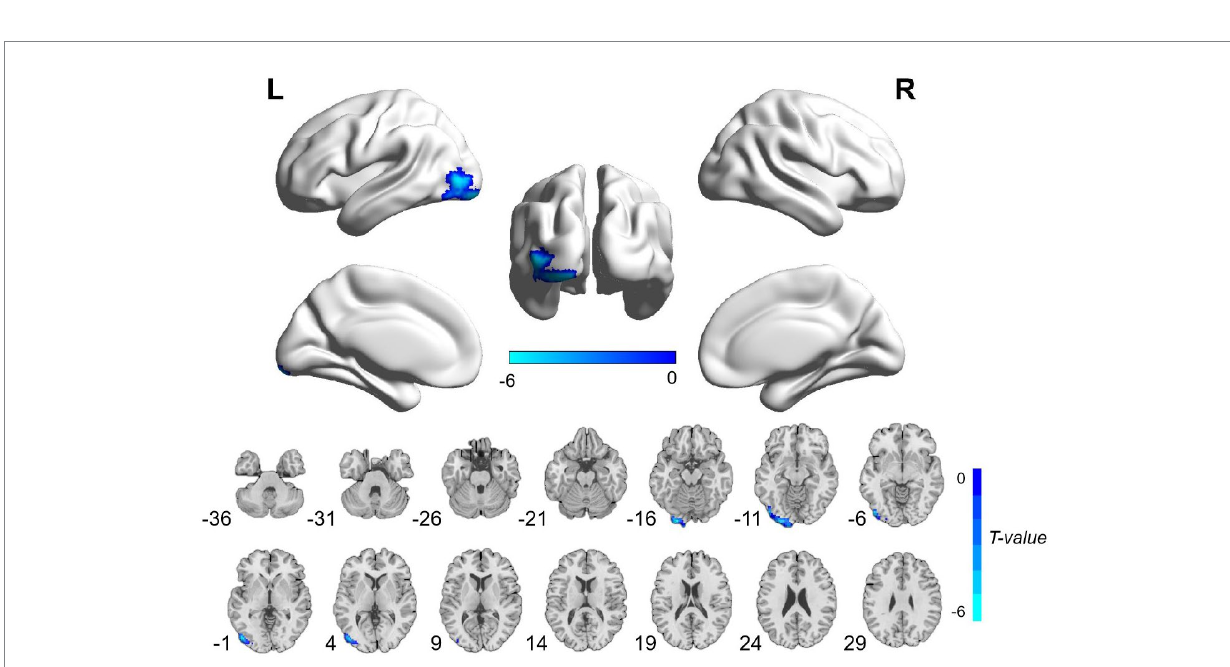
FIGURE 2 Brain regions with significant ReHo differences between patients with cardiac arrest and healthy controls. The difference primarily existed in the left inferior occipital gyrus and middle occipital gyrus (voxel-level p < 0.001 and cluster-level p < 0.05 with GRF correction). L, left; R, right; ReHo, regional homogeneity; GRF, Gaussian random